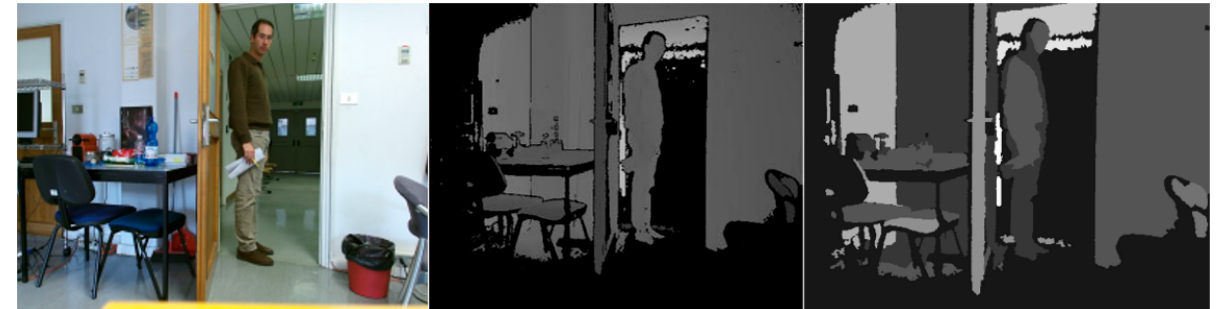
Figure 2. Raw color image ( left ), depth map ( middle ), and segmentation map ( right ).